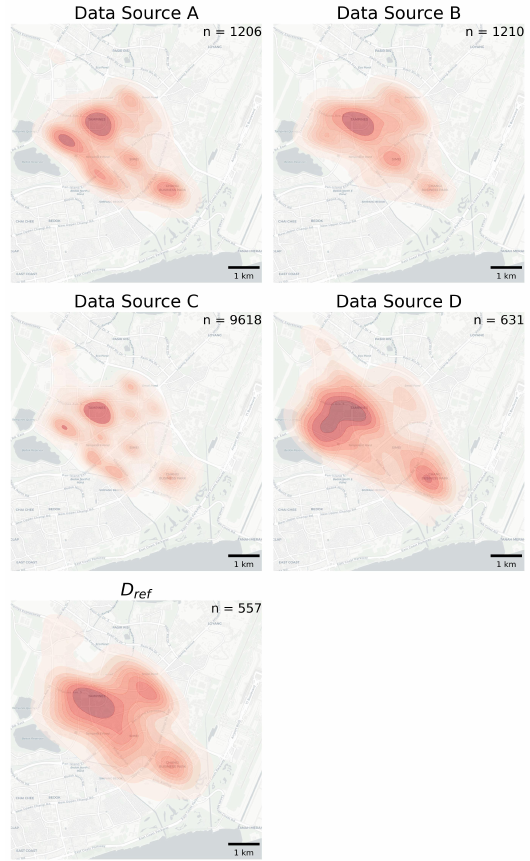
Figure A1. Heatmaps of POIs from each data source within study area. Numbers on top-right corner are number of POIs in data source. Map tiles by Carto, under CC BY 3.0. Data by OpenStreetMap, under